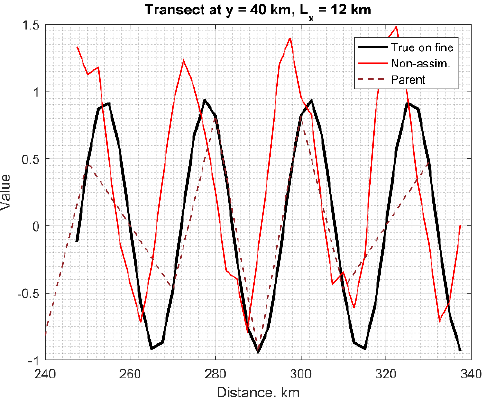
Figure 10. Transects of true field on the fine grid (black) and outputs from the parent (dashed brown) and non-assimilated child (red) models.